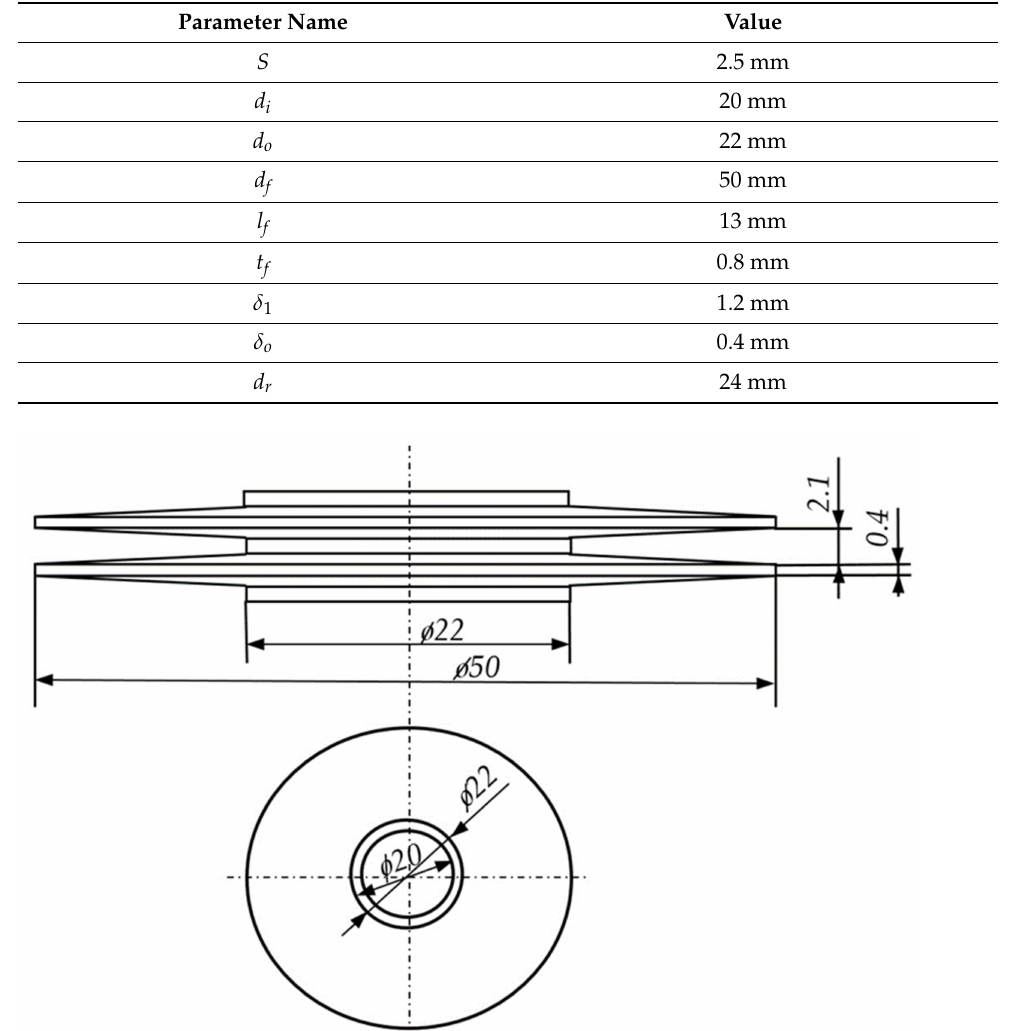
Figure 6. Finned surface heat pipe heat exchanger